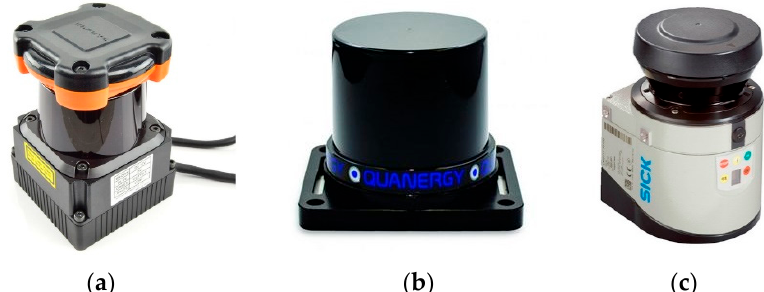
Figure 2. Common 2D LiDAR photos: ( a ) Hokuyo Utm-30LX scanning laser rangefinder LiDAR; ( b ) Quanergy's M8 LiDAR sensor; ( c ) SICK’s LMS151 field detection laser scanner